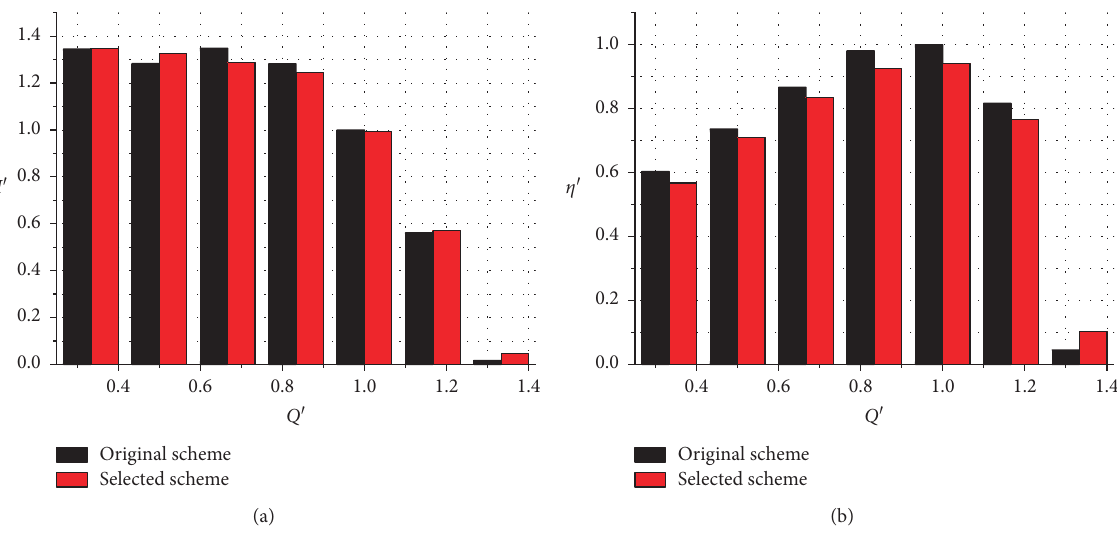
Figure 7: Hydraulic performance of the selected scheme and the original scheme: (a) Q ′ -H ′ curve; (b) Q ′ -η ′